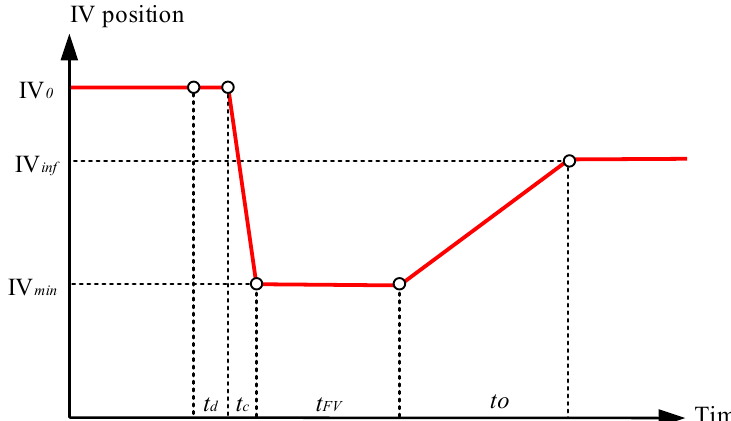
Figure 1. Positions of the intercept valve during TFV.